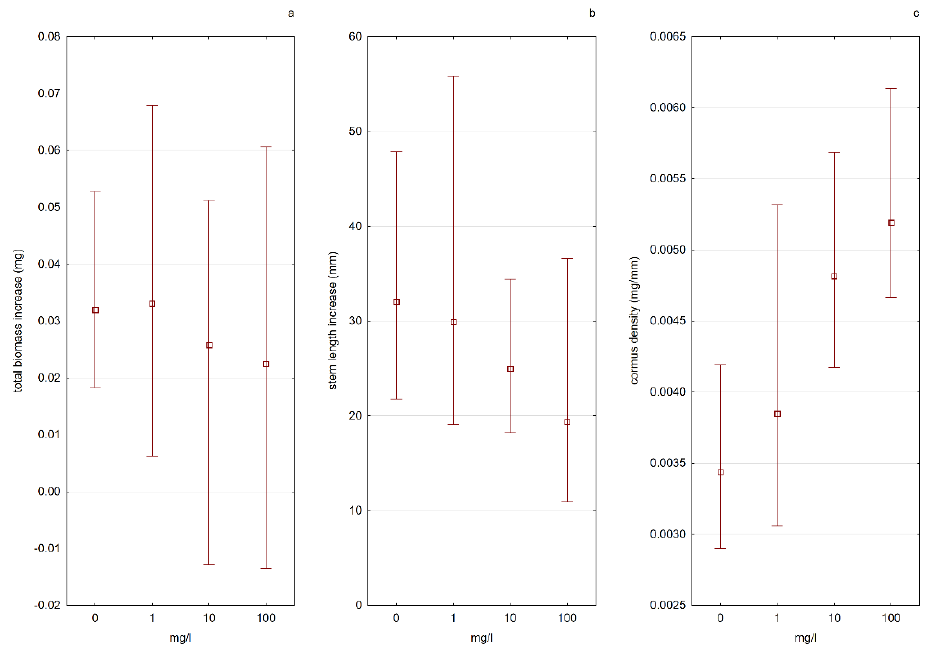
Figure 7. Influence of the content of available N-NO 3 ions on the tested plant features, determining the growth efficiency (( a ) — total biomass increase, ( b ) — stem length, ( c ) — cormus density). Whiskers indicate the range of values, and squares indicate the mean.